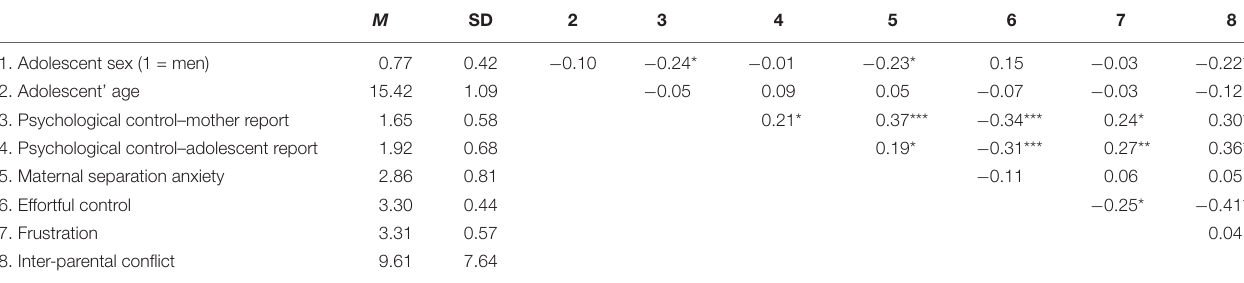
TABLE 1 | Descriptive statistics and correlations.